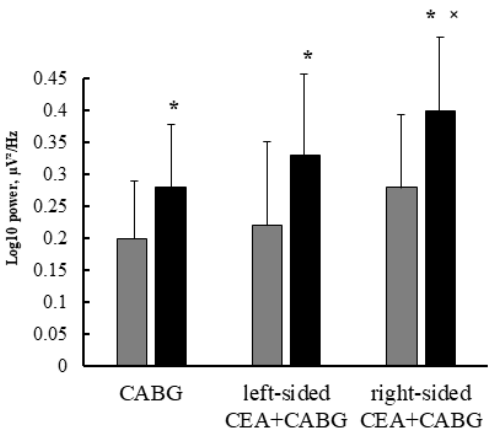
Figure 4. The postoperative theta1 rhythm power changes in the patients undergoing isolated CABG and simultaneous intervention (CABG+CEA): grey columns—the CABG patients, dark columns—the CABG+CEA patients; error bars denote SE, *— p < 0.05 Newman–Keuls multiple comparison test for the postoperative indicators in comparison to preoperative levels, ˟ — p < 0.05 Newman–Keuls multiple comparison test for the postoperative indicators in CABG+CEA group as compared to CABG group.